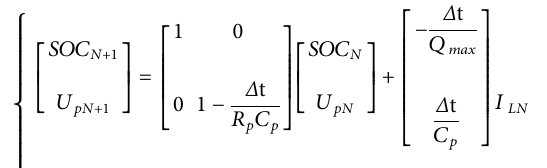
FIGURE 3 Connection block diagram of SOC estimation based on EKF.